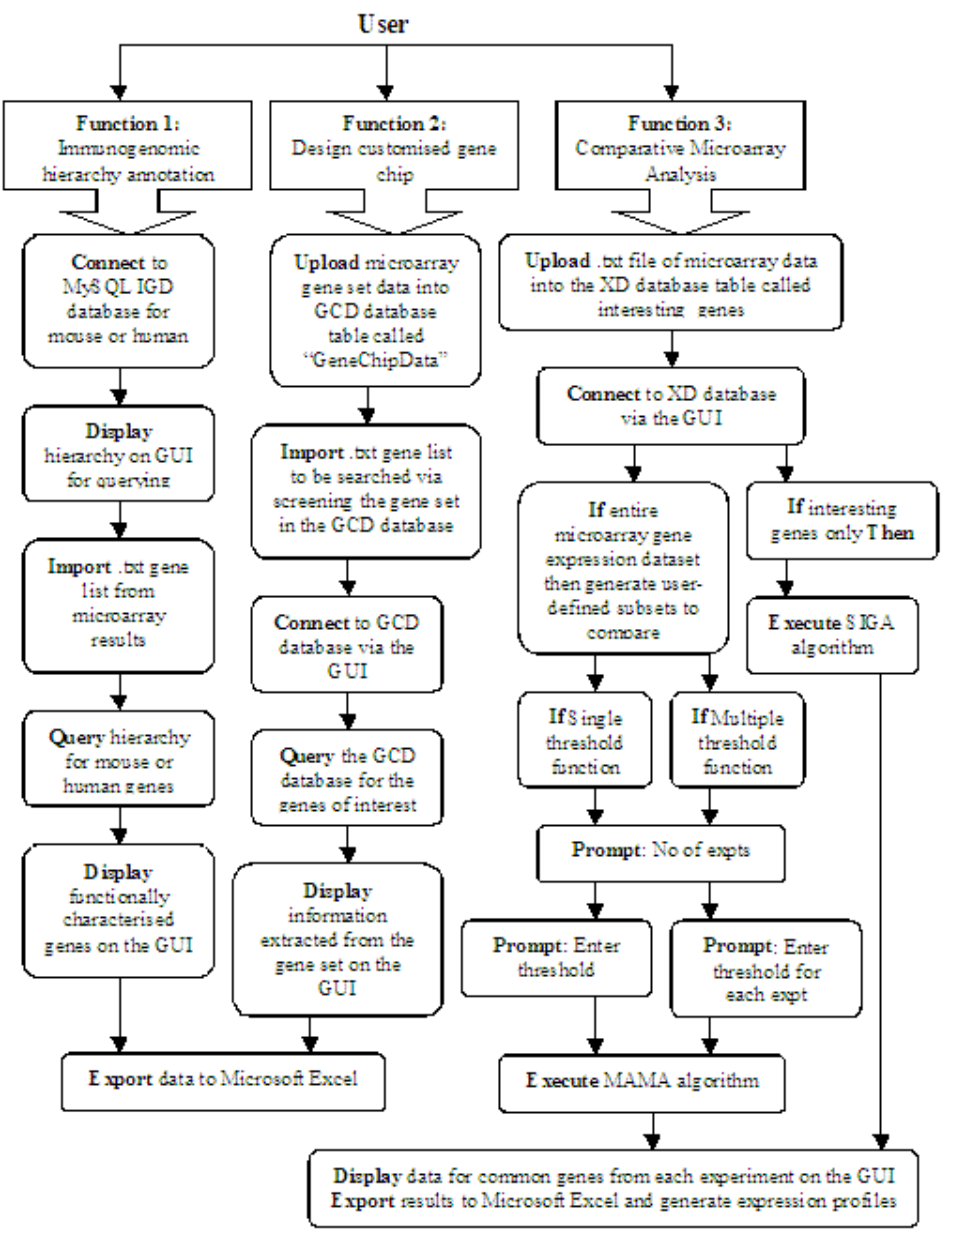
Figure 1: Functionality of CIDA CIDA carries out several steps during the set functionalities for interpreting, manipulating or analysing microarray gene expression data. Each function of the software requires the microarray data to be imported as a tab delimited text file into the underlying MySQL database before further use. Following data import into the database tables, the databases are queried and results displayed on the GUI and also exported to Microsoft